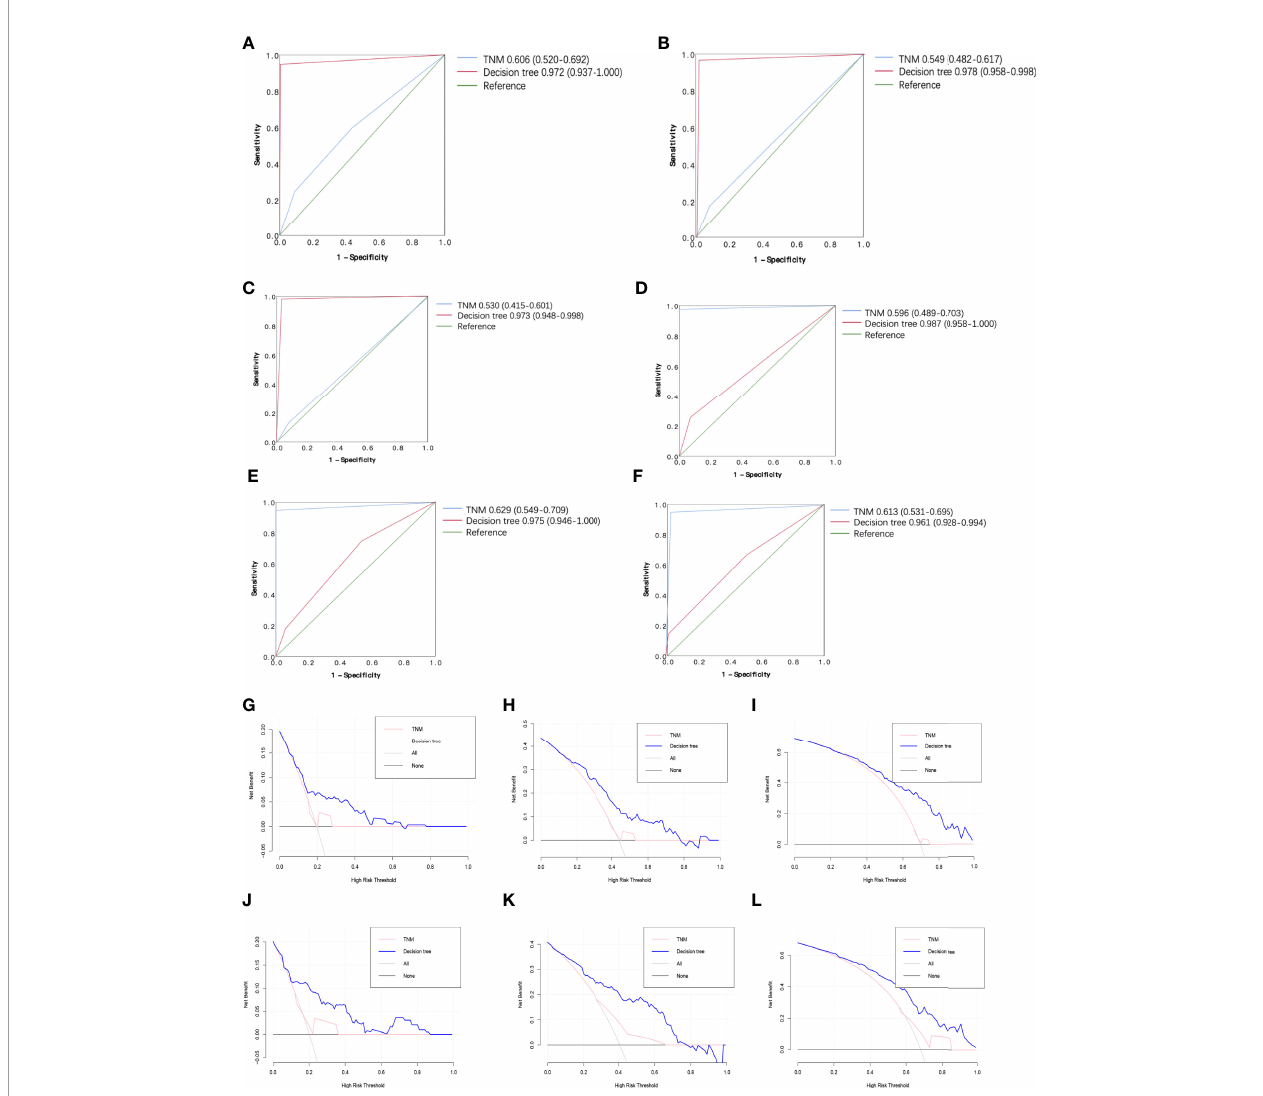
FIGURE 5 | Receiver operating characteristic (ROC) curve and the decision curve analysis (DCA) of the decision tree model and AJCC TNM stage model. (A) 0.5- year R OC curves of the decision tree model and AJCC TNM stage model in the training cohort. (B) 1-year ROC curves of the decision tree mod el and AJCC TNM stage model in the training cohort. (C) 3-year ROC curves of the decision tree model and AJCC TNM stage model in the training cohort. (D) 0.5-year ROC curves of the decision tree model and AJCC TNM stage mod el in the validation cohort. (E) 1-year ROC curves of the decision tree model and AJ CC TNM stage model in the validation cohort. (F) 3-year R OC curves of the decision tree model and AJCC TNM stage model in the validation cohort. (G) 0.5-year DCA of the decision tree model and AJCC TNM stage model i n the training cohort. (H) 1-year DCA of the decision tree model and AJCC TNM stage model in the training cohort. (I) 3-year DCA of the decision tree model and AJCC TNM stage model in the training cohort. (J) 0.5-year DCA of the decision tree model and A J CC TNM stage model in the validation cohort. (K) 1-year DCA of the decision tree model and AJCC TNM stage model in the validation cohort. (L) 3-year DCA of the decision tree model and AJCC TNM stage mod el in the validation